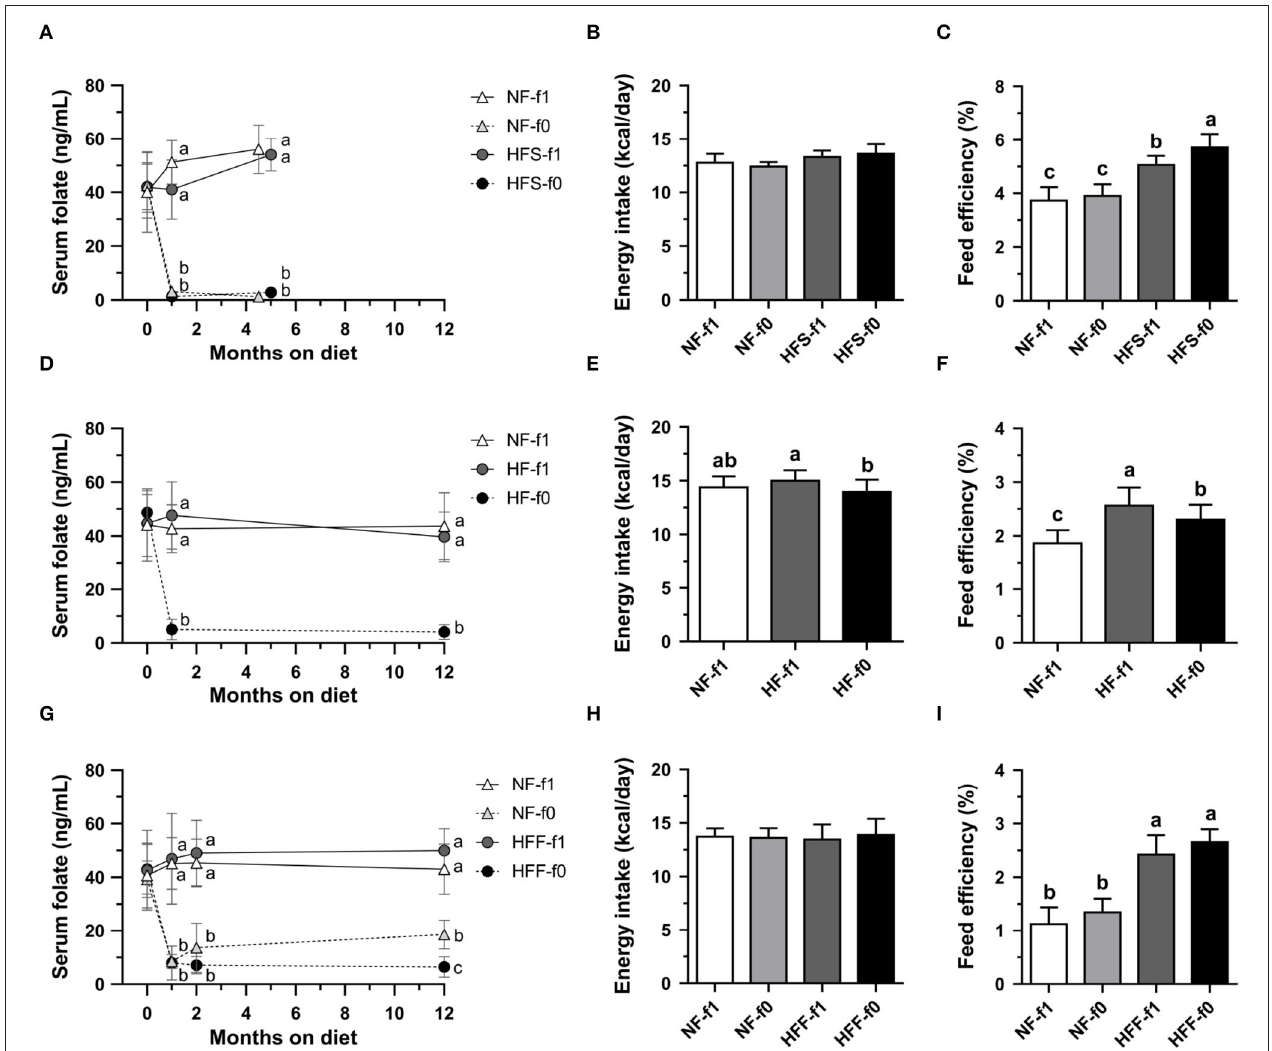
FIGURE 2 | Serum folate concentration, energy intake and feed efficiency of C57BL/6 mice fed HFD (HF) containing different carbohydrate source with (f1) or without (f0) folate. (A) Serum folate, (B) energy intake, and (C) feed efficiency from mice fed either NFor HF containing high-sucrose (HFS) diet for 4.5–5 months. (D–F) from mice fed either NF or HF diet for 12 months. (G–I) from mice fed either NF or HF containing high-fructose (HFF) diet for 12 months. Data mean ± SD ( n = 8–16 per group). The different letters are indicated significant differences ( p < 0.05) among groups analyzed using one-way ANOVA and Duncan’s post-hoc test.